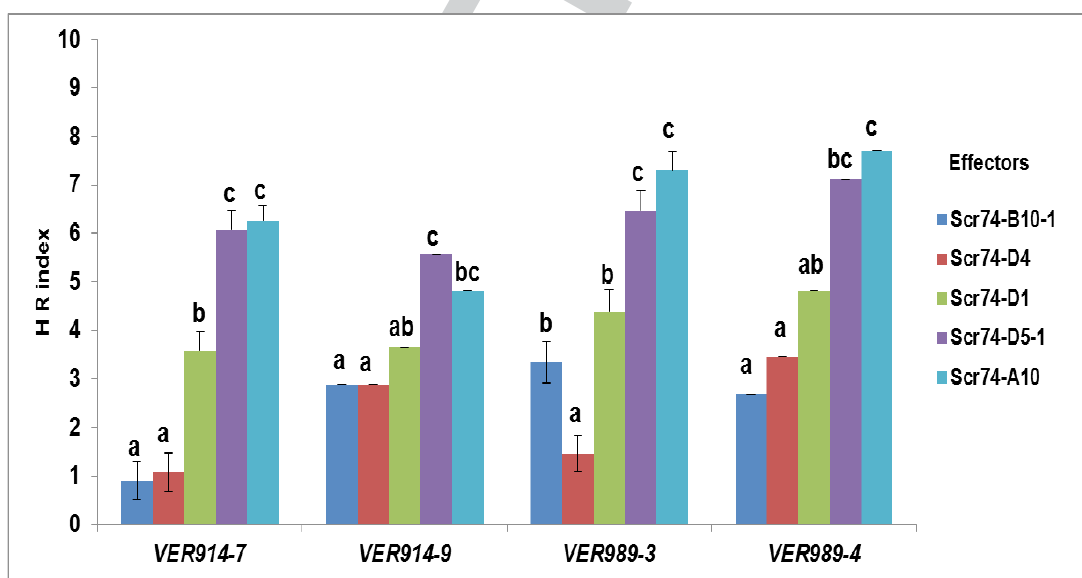
Figure 5. Plant cell death response to five effectors on four genotypes and their significance at p<0.01. Effectors with same letter did not have significant difference and vice versa